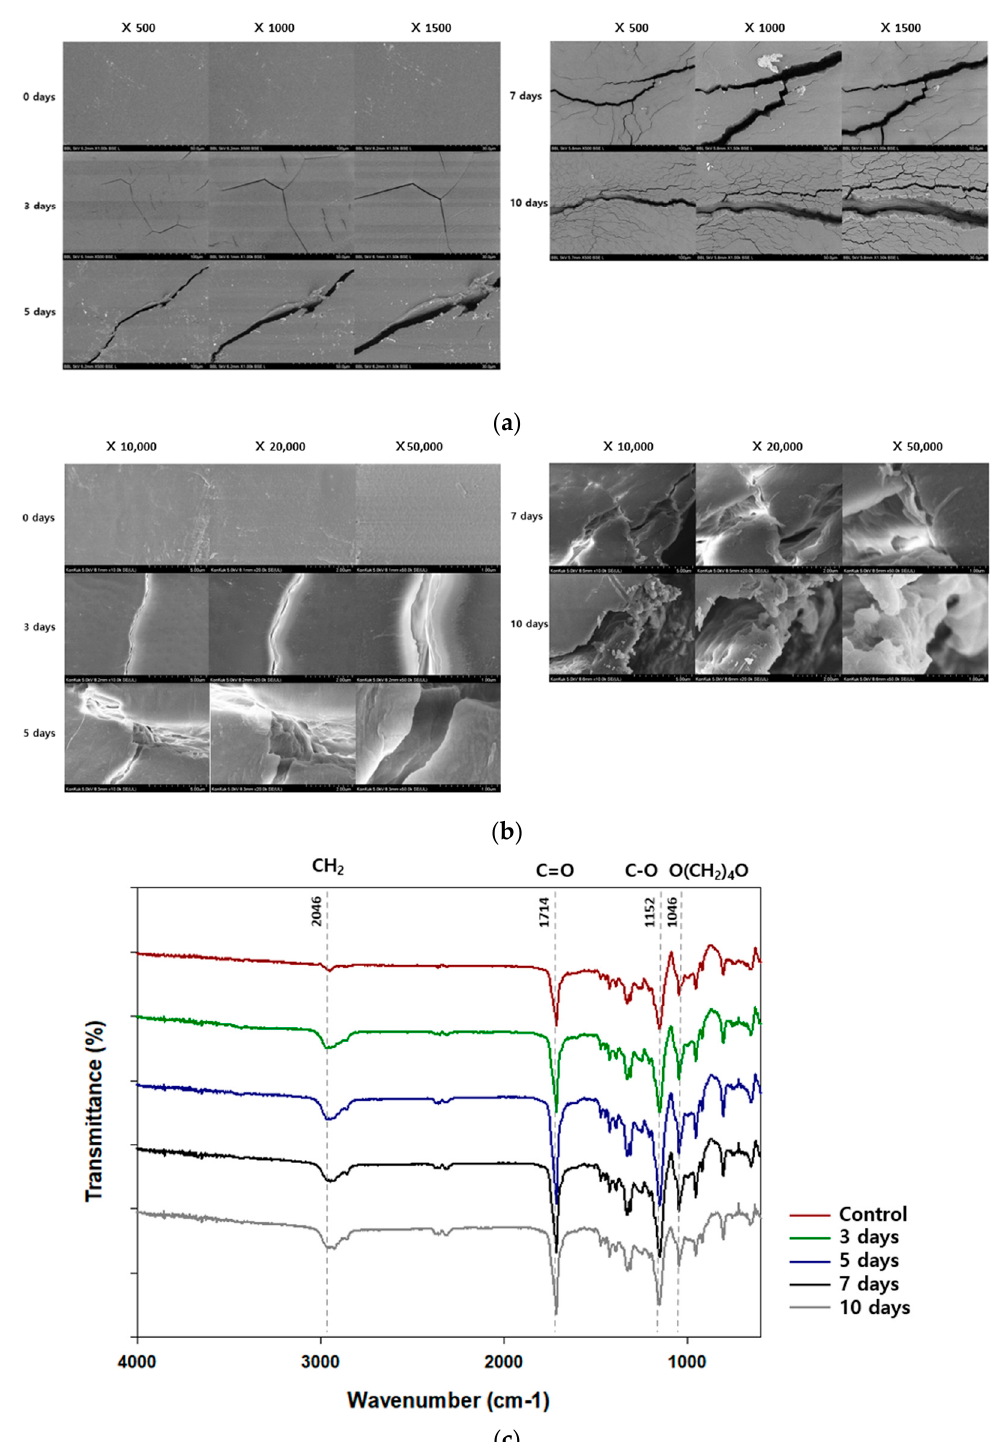
Figure 5. Changes in the surface and functional group of PBS films after degradation. ( a ) The surface of PBS was observed using SEM after 3, 5, 7, and 10 days of cultivation. ( b ) Cracks and rough surfaces formed after degradation were also observed using FE-SEM with high magnification. ( c ) Changes in functional groups were confirmed using FI-IR analysis. After degradation by Terribacillus sp. JY49, peak intensities changed with time.